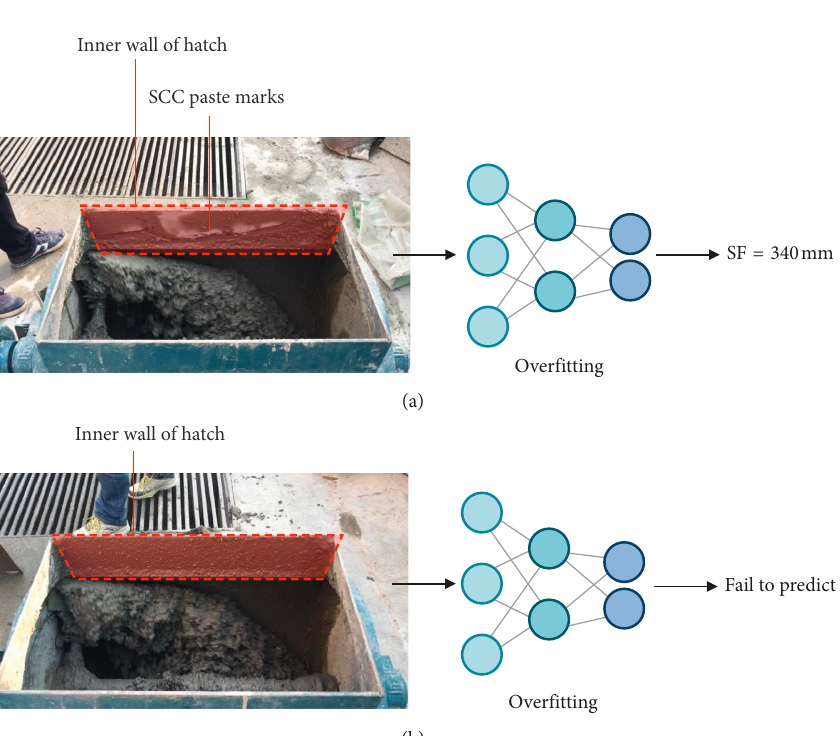
Figure 5: Overfitting example: (a) the mark being learned as the feature of SF � 340 mm; (b) resulting inaccuracy in prediction of image of the same SF